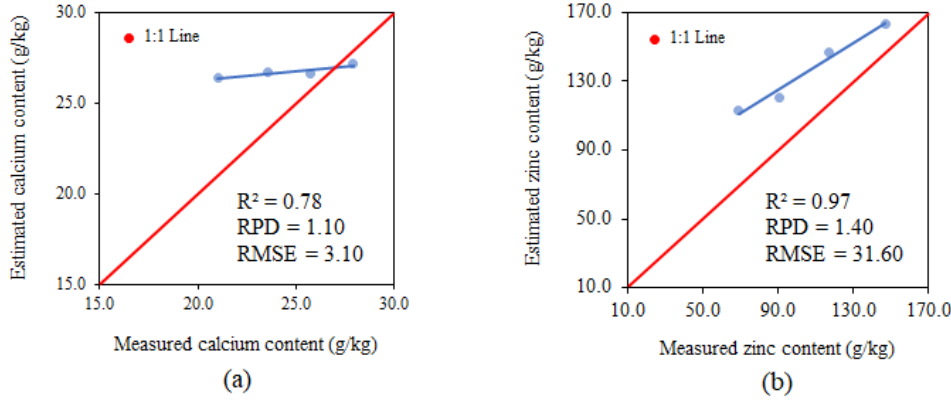
Figure 10. Relationships between the measured and estimated levels of calcium ( a ) and zinc ( b ) at phenological stage V4.